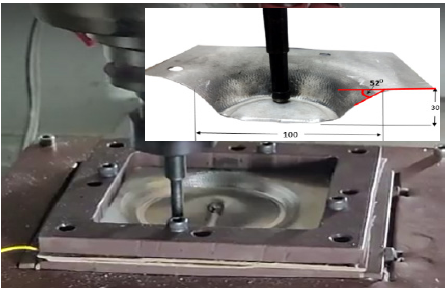
Figure 2. Sectional view of variable wall angle geometry .